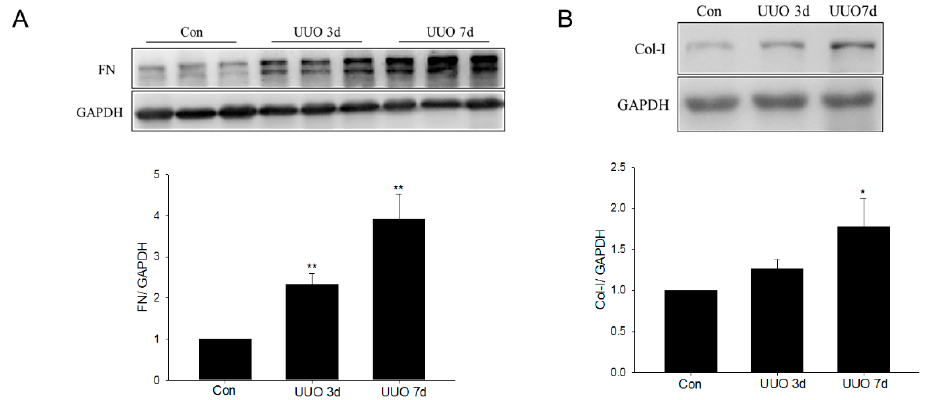
Figure 1. Cont. Figure 2. Cont